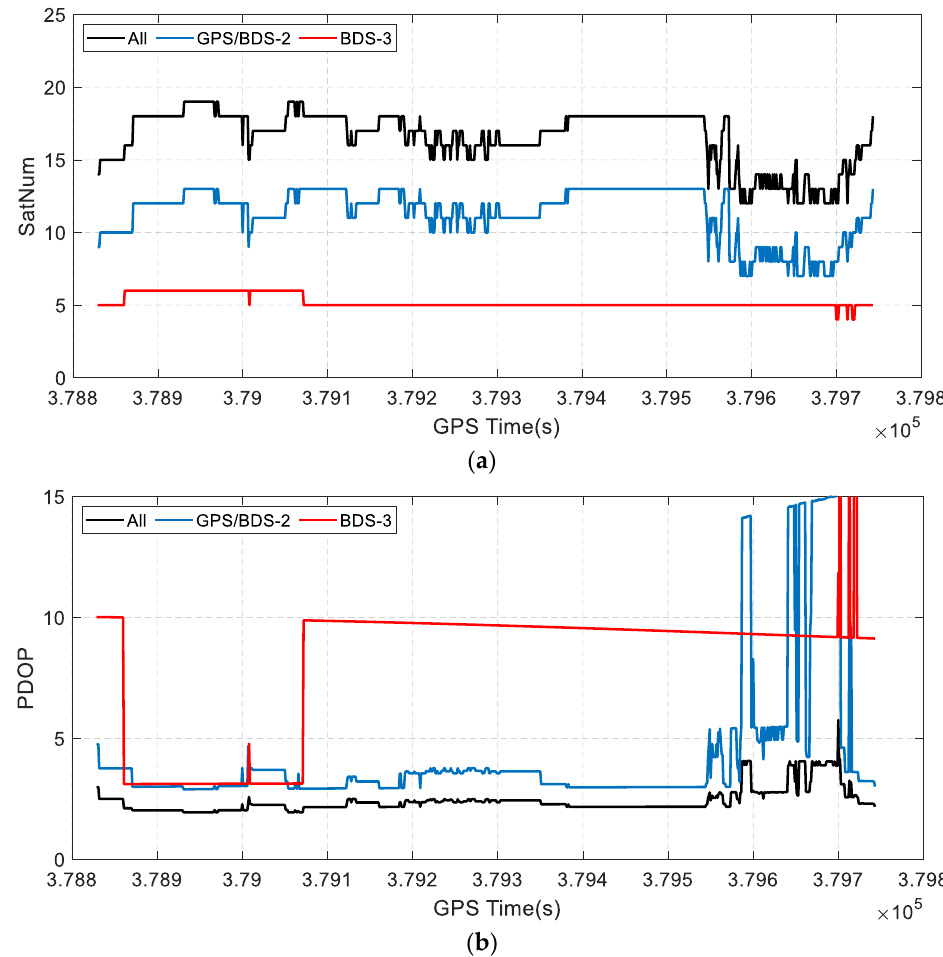
Figure 5. The number of visible satellites and PDOP of GPS/BDS-2, BDS-3, and GPS/BDS-2/BDS-3 (all) in the rover station: ( a ) number of satellites; ( b ) PDOP. (all) in the rover station: ( a ) number of satellites; ( b )